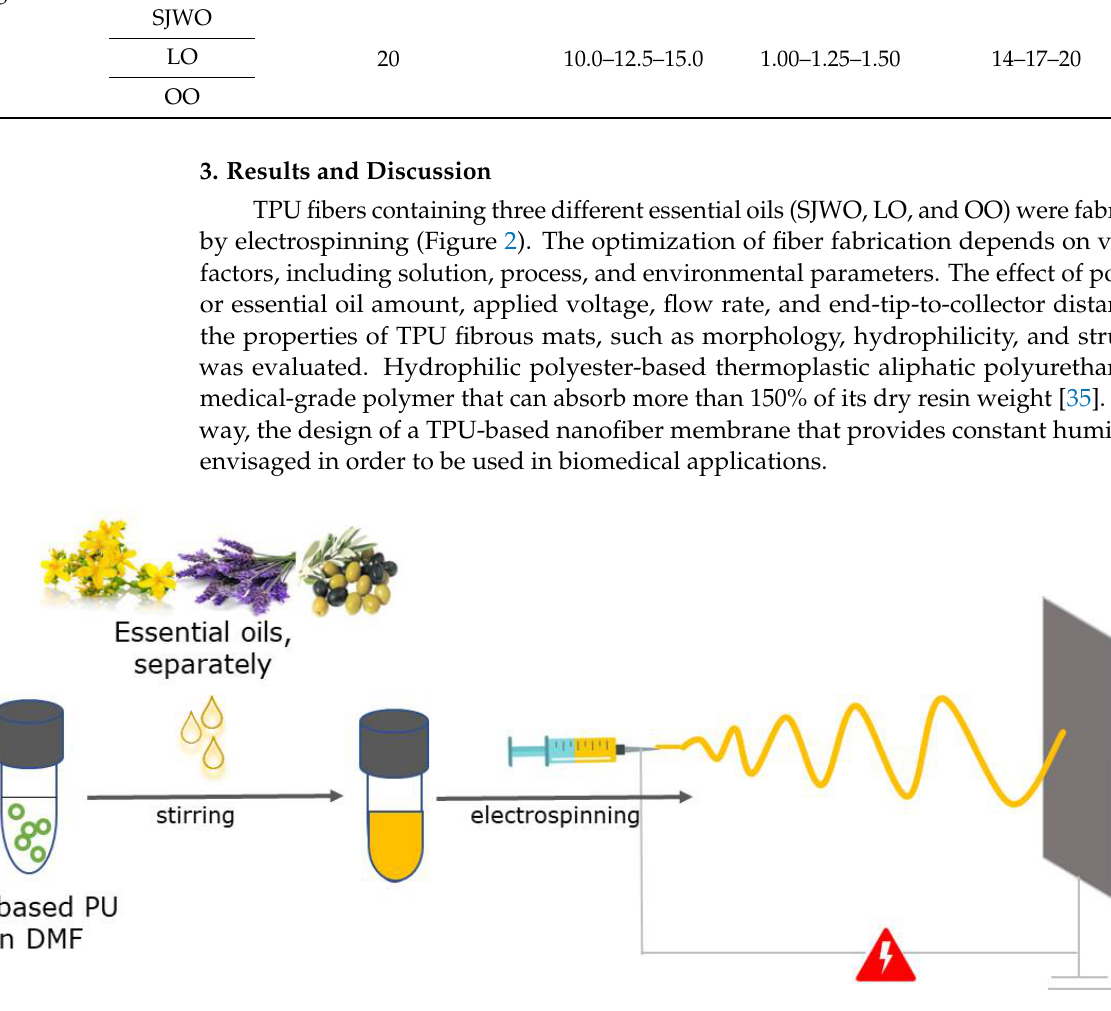
Figure 2. Schematic representation of TPU/EO composite fiber